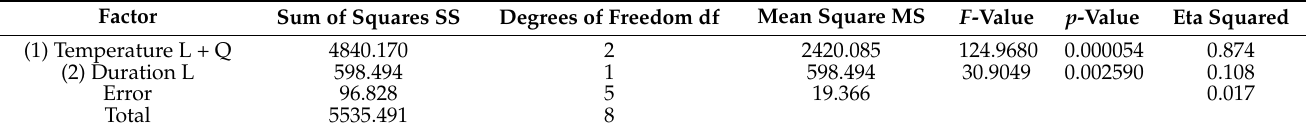
Table 7. Analysis of variance of the thickness of the compact part of the boride layer.